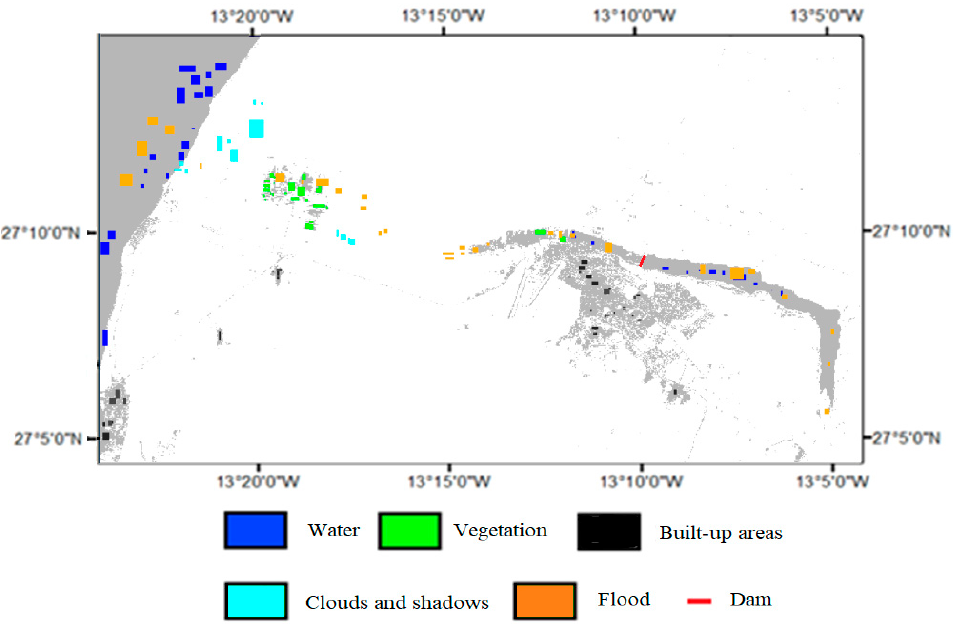
Figure 7. Ground-truth data collected during field surveys.